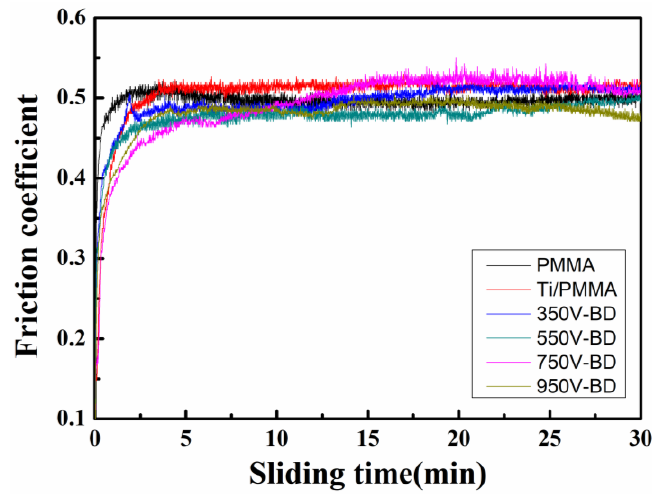
Figure 8. Friction coefficient curves of PMMA, Ti/PMMA, and the films prepared on Ti/PMMA at a different substrate bias without conductive material.